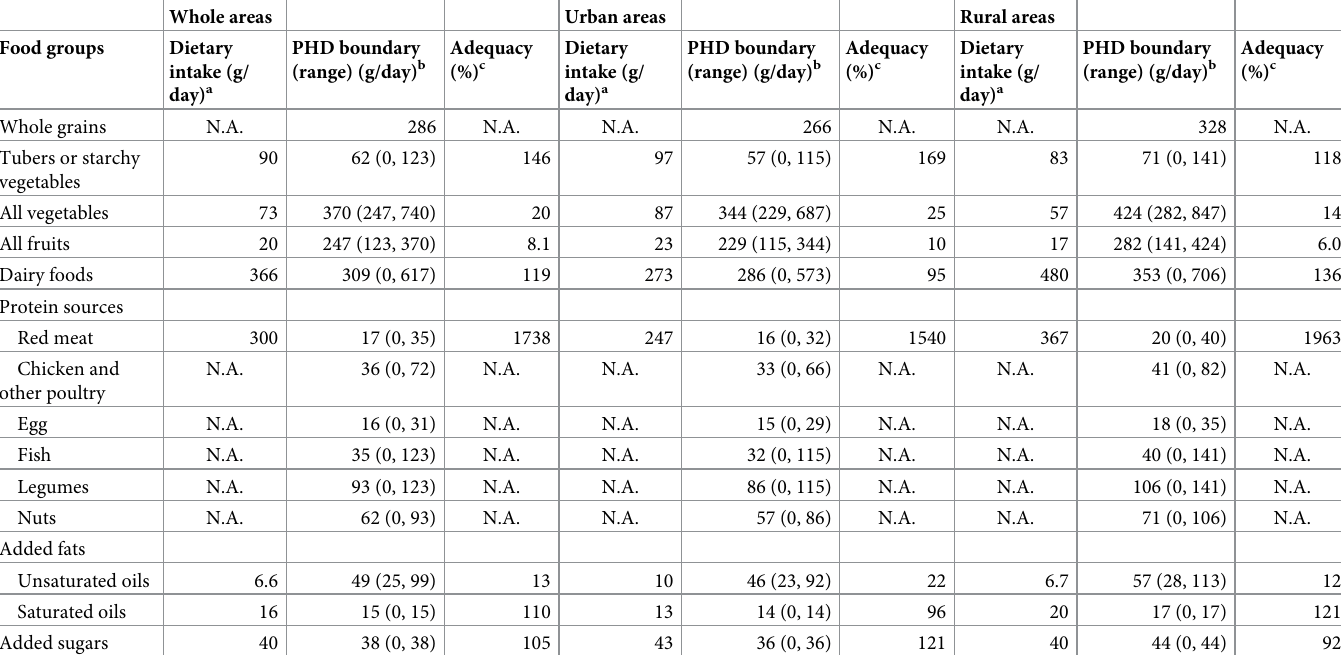
N.A.: not available, PHD: Planetary Health Diet a The average dietary intake (g/day) was referenced according to the Household socio-economic survey (HSES) 2019 among 11,197 households (3,600 in urban areas and 7,597 in rural areas).